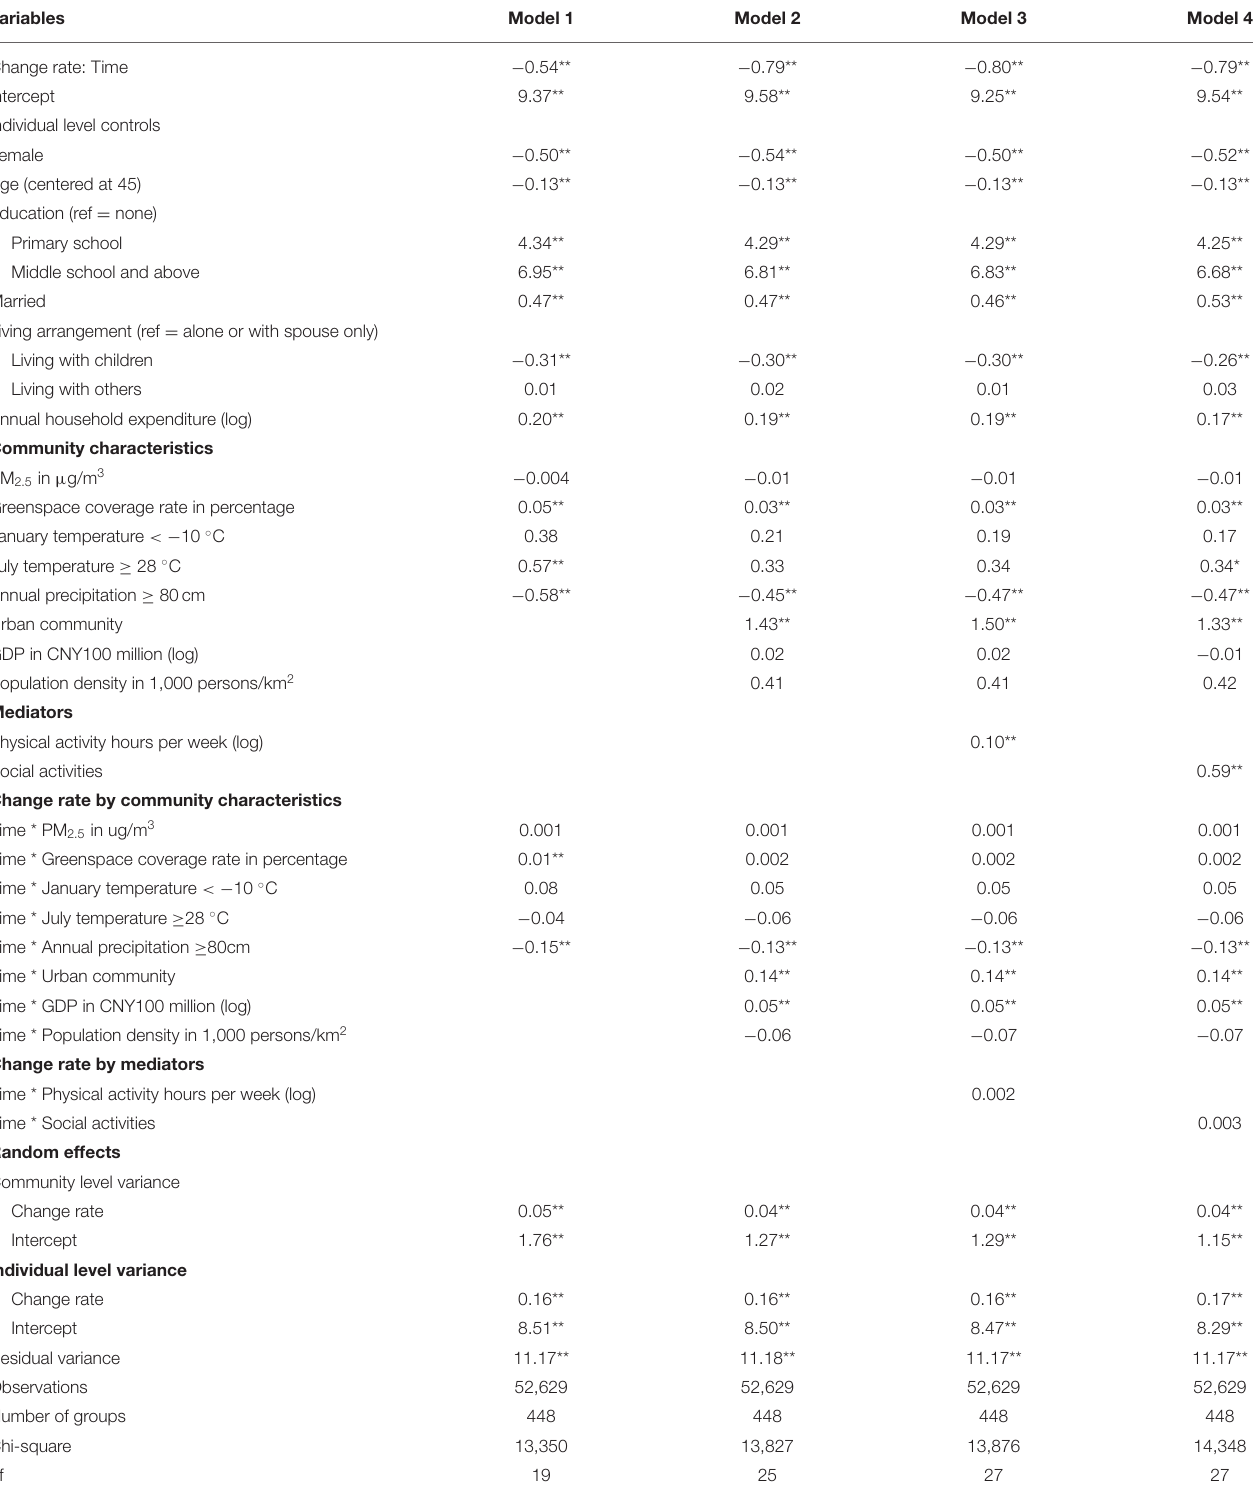
TABLE 2 | Regression coefficients from multilevel linear growth curve model of trajectories of cognitive function in mid and later